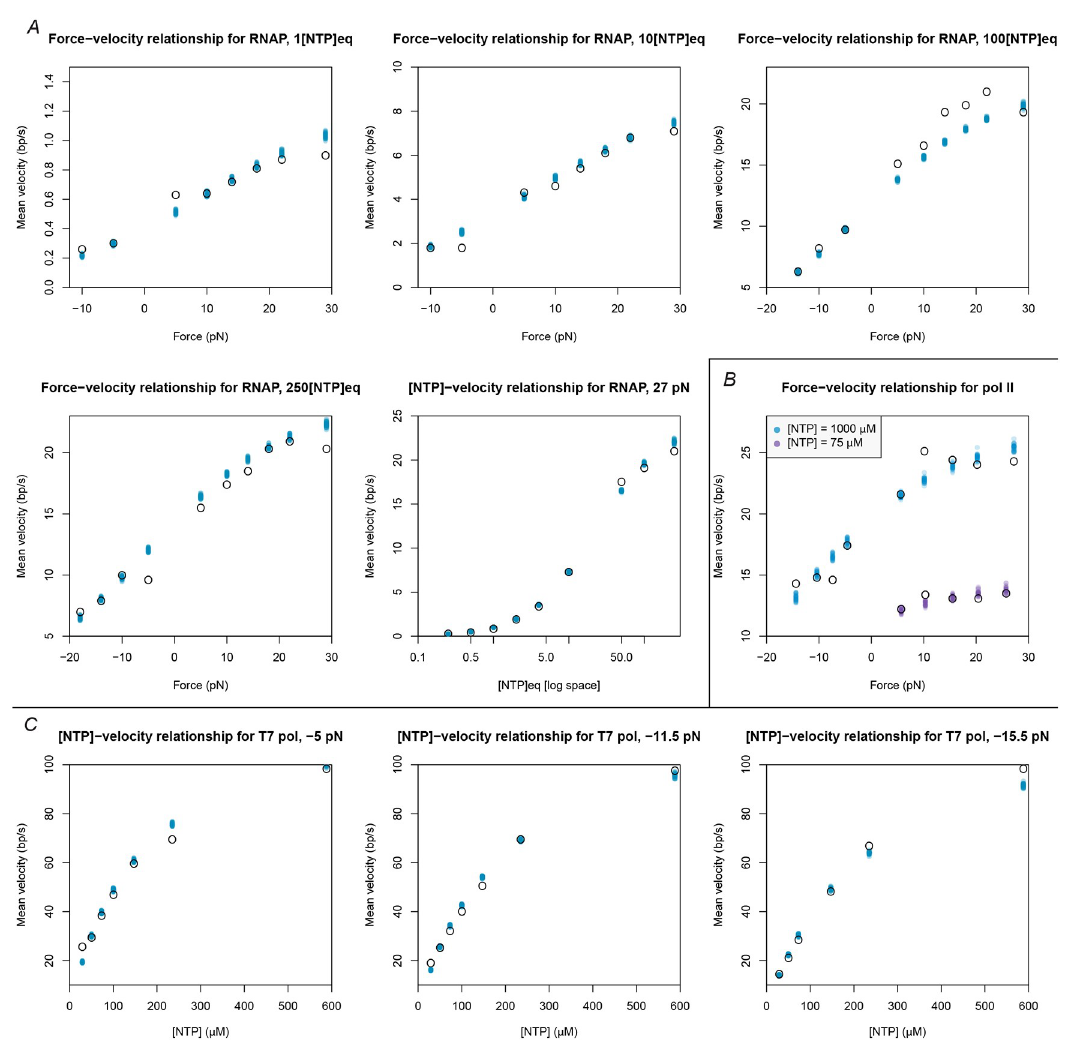
Fig 6. Posterior distributions of simulated velocities. Black open circles represent experimentally measured mean velocities reported in the original publication for (A) RNAP, (B) pol II, and (C) T7 pol [4, 26, 27]. Each coloured dot represents a single sample simulated from the posterior distribution of parameters/models for the respective polymerase. 30 samples were generated from each of the three posterior distributions. For RNAP, [NTP] is defined as [ATP] = 5 μ M, [CTP] = 2.5 μ M, [GTP] = 10 μ M, and [UTP] = eq 10 μ